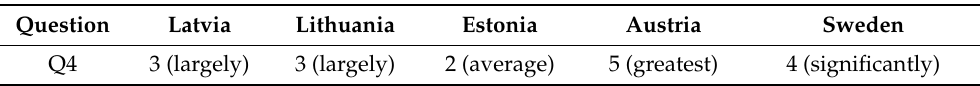
Table 4. The scores of expert assessment from transnational comparison, respectively, according to question